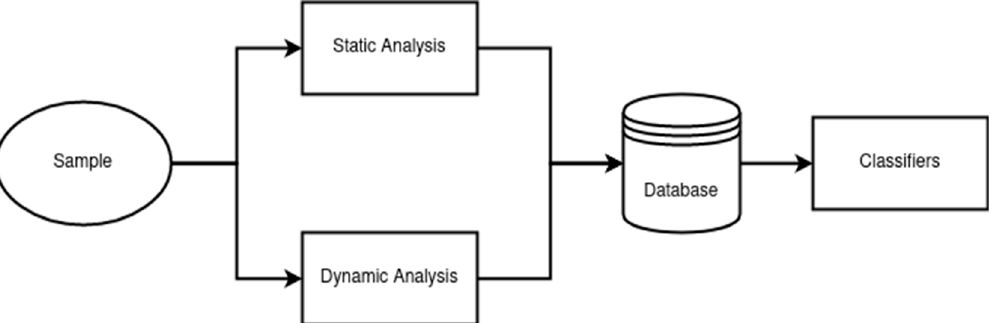
Figure 1. Sisyfos platform architecture.